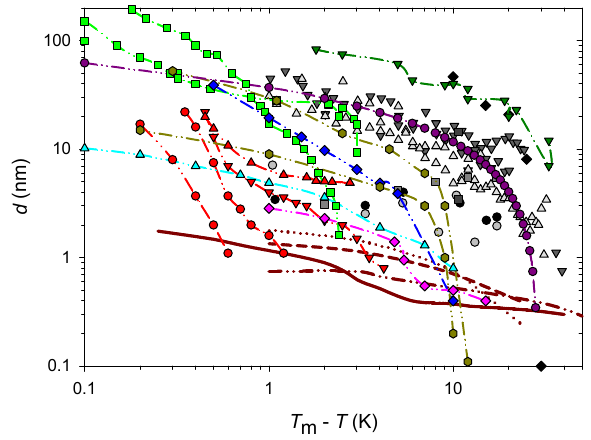
Figure 1. QLL thickness determined with different experimen- tal and simulation techniques: AFM measurements by Pittenger et al. (2001) with Si tips (grey circle) and hydrophobic coated silicon tips (black circle), by Döppenschmidt et al. (2000) in air (dark grey triangle) and vacuum (light grey triangle), by Petrenko (1997) (dark grey square), and by Bluhm and Salmeron (1999) and Bluhm et al. (2000) (grey square). IFM measurements by Goertz et al. (2009) (black diamond). Brewster reflectometry by Elbaum et al. (1993) (red circle and triangles; different symbols correspond to different experiments). Ellipsometry by Beaglehole and Nason (1980) (blue diamond) and Furukawa et al. (1987) (light green square). XPS by Bluhm et al. (2002) (magenta diamond). Fourier-transform in- frared spectroscopy (FTIR) by Sadtchenko and Ewing (2002) (cyan triangle). Proton dispersion by Golecki and Jaccard (1977) (green triangle). Grazing-angle X-ray diffraction (GXRD) by Dosch et al. (1995, 1996) and Lied et al. (1994) (olive hexagon). Simula- tion results by Limmer and Chandler (2002) (maroon line); Fu- rukawa and Nada (1997) (dotted maroon line and dashed maroon line) for the prismatic and basal planes, respectively; and by Conde et al. (2008) (dashed and dotted maroon line) for the basal